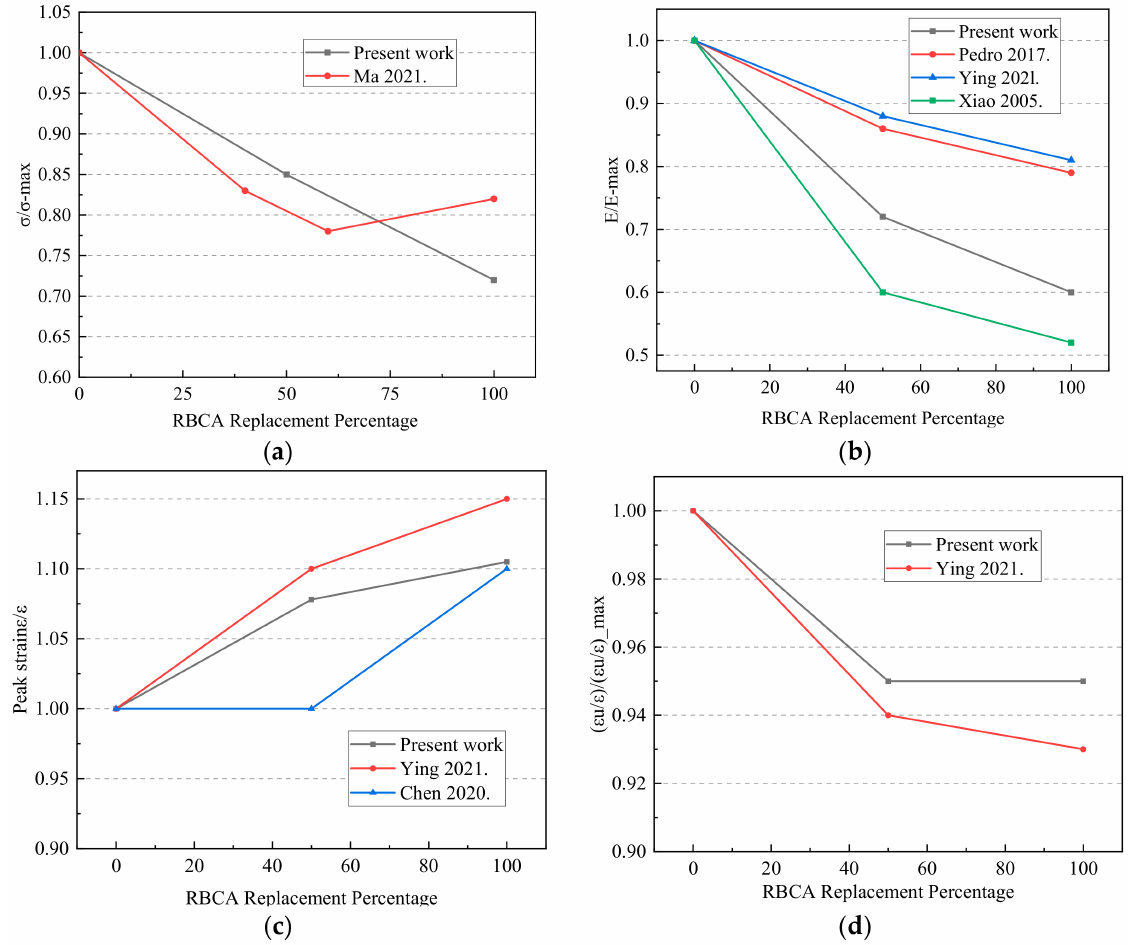
Figure 13. The effect of RCA replacement rate: ( a ) compressive strength, ( b ) elastic modulus, ( c ) peak strain, ( d ) ratio of ultimate strain to peak